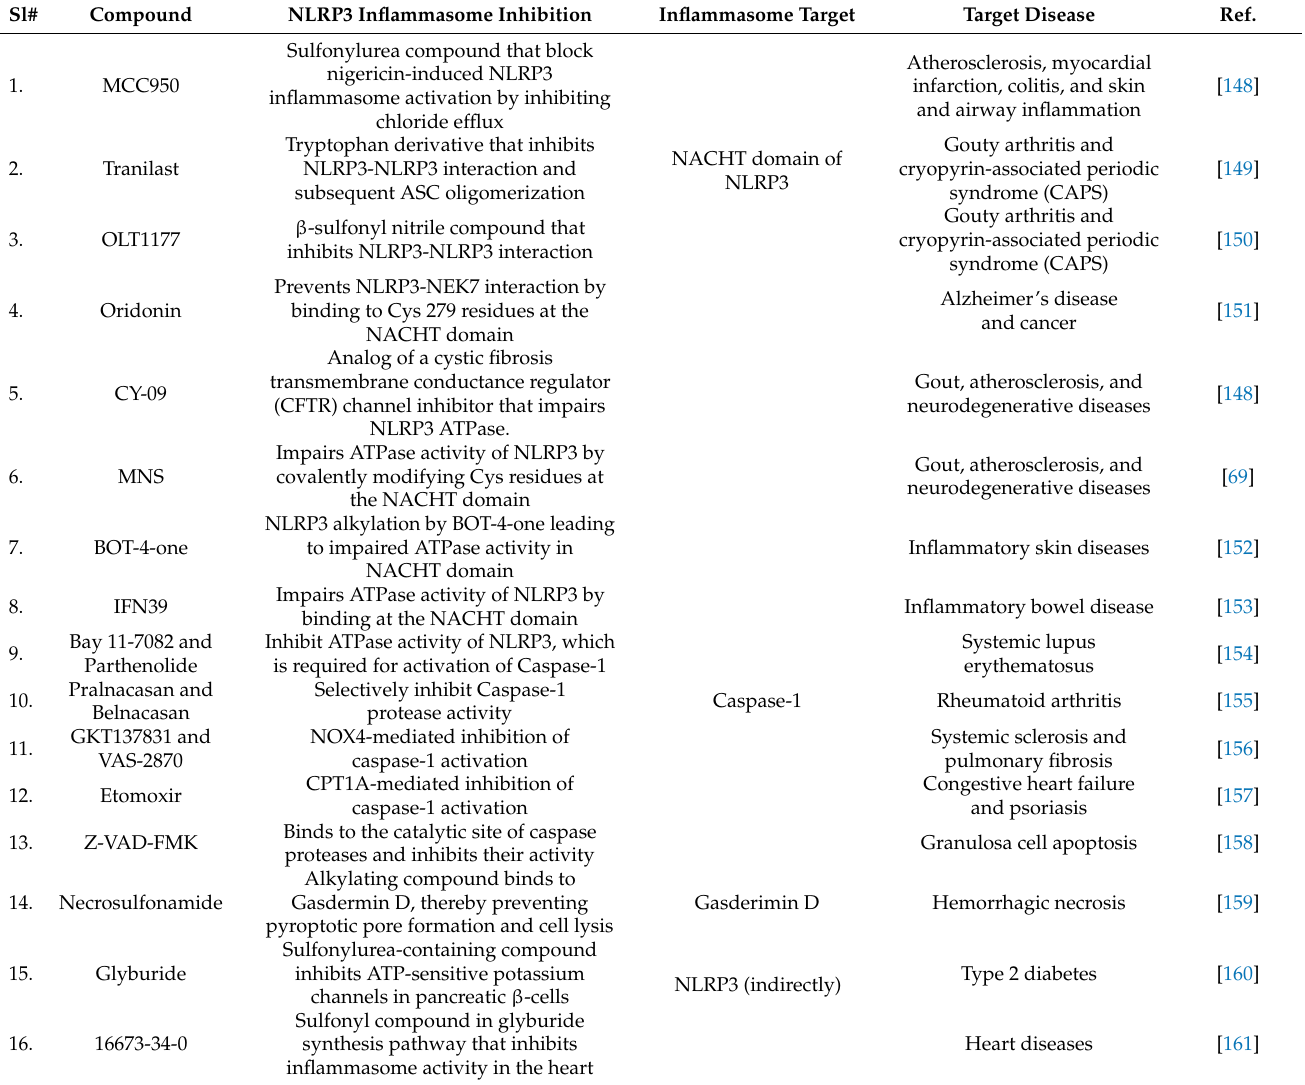
Table 3. Potential pharmacological inhibitors of NLRP3 inflammasome